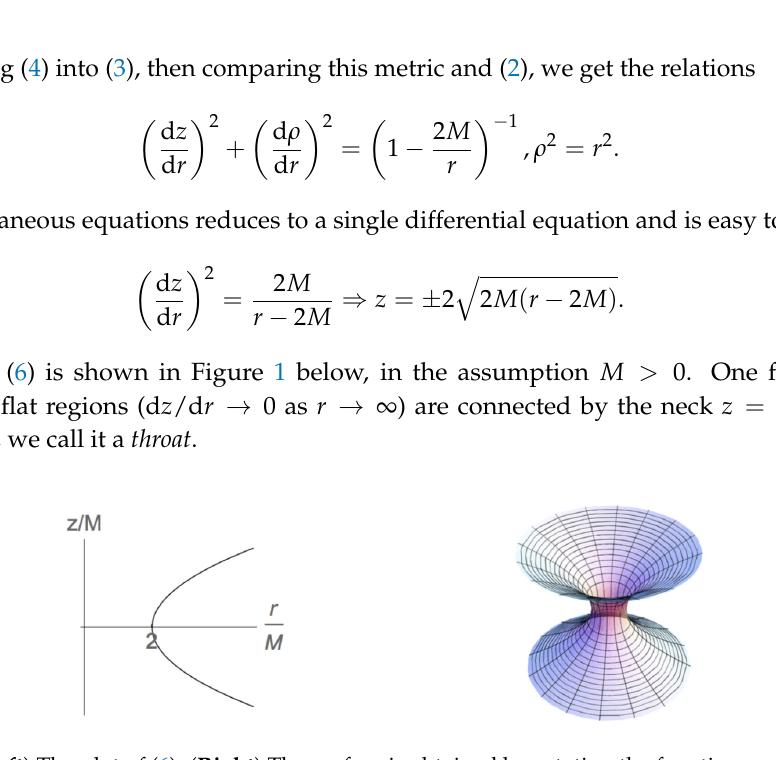
Figure 1. ( Left ) The plot of (6). ( Right ) The surface is obtained by rotating the function around z axis in the φ direction. The narrowest surface z = 0 corresponds to r = 2 M .